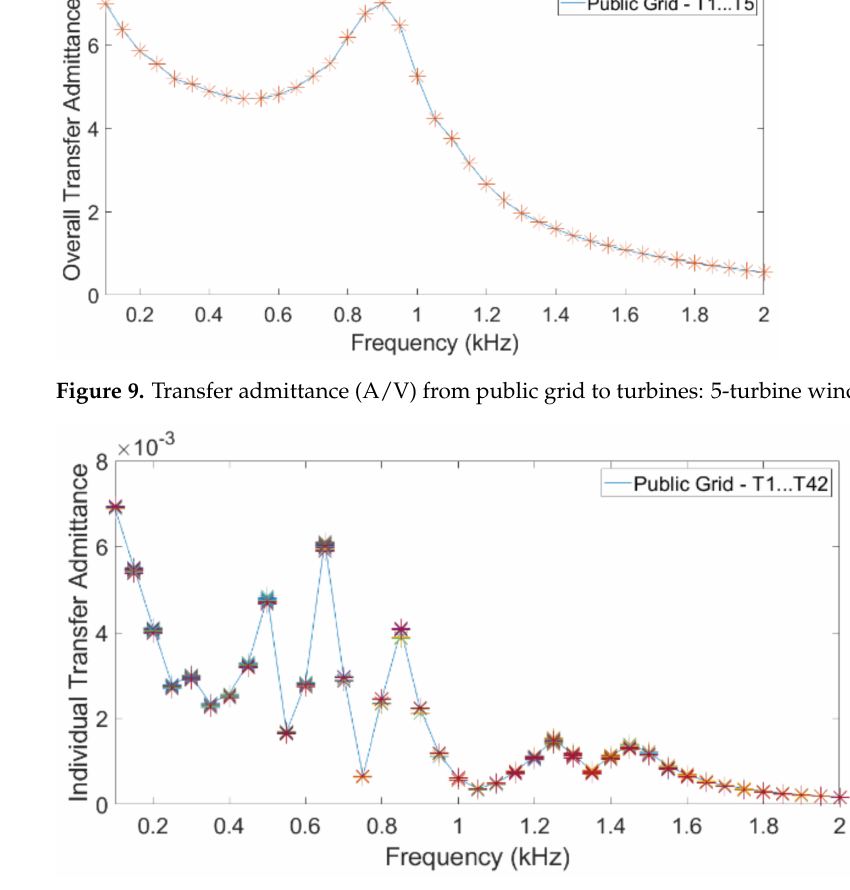
Figure 10. Transfer admittance (A/V) from public grid to turbines: 42-turbine wind power